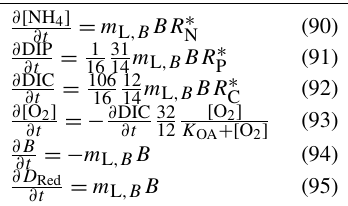
Table 16. Equations for linear phytoplankton mortality.